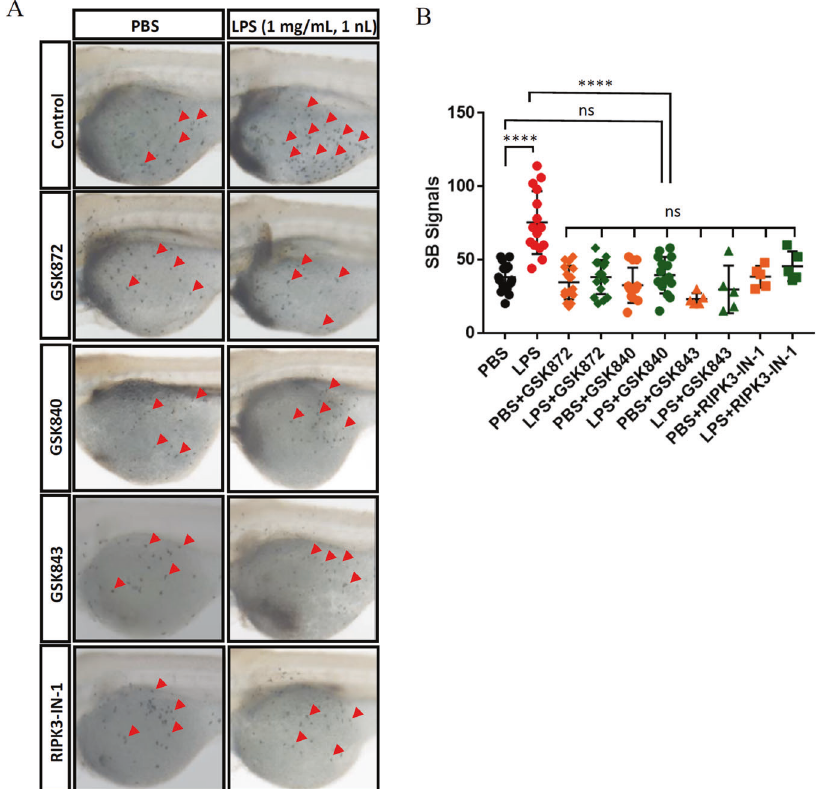
Fig. 6 Targeting Ripk3 could inhibit LPS-induced in fl ammation. A Attenuated LPS-induced neutrophil accumulation upon Ripk3 inhibition. The WT larvae were pre-treated with Ripk3 inhibitors and then injected with LPS at 3 dpf. The neutrophil accumulation (red arrows pointed) was signi fi cantly inhibited by Ripk3 inhibitors at 5 hpi. B Quanti fi cation of ( A ) ( n ≥ 5, one-way